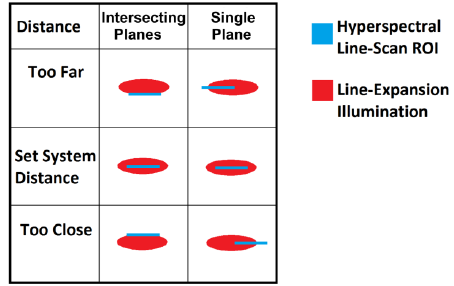
Figure 4. Alignment of imaging and illumination fields as a function of distance from the optics and the positioning of the laser relative to the camera.